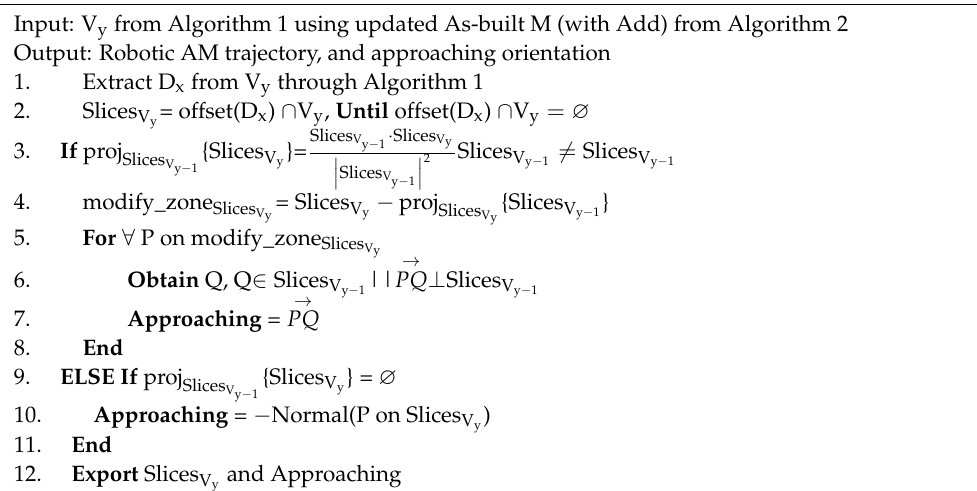
Algorithm 3 : Trajectory Planning Generation.